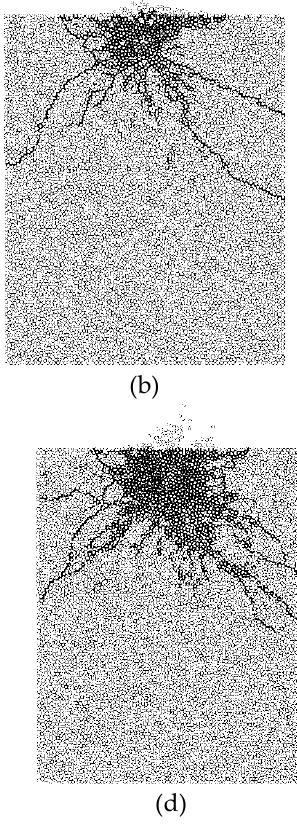
Figure 13. Interior cracking and crack propagation of EPB in granite at t = 200 μs using different voltages with C = 0.5 μF : ( a ) U = 10 kV, ( b ) U = 15 kV, ( c ) U = 20kV, and ( d ) U = 30kV.